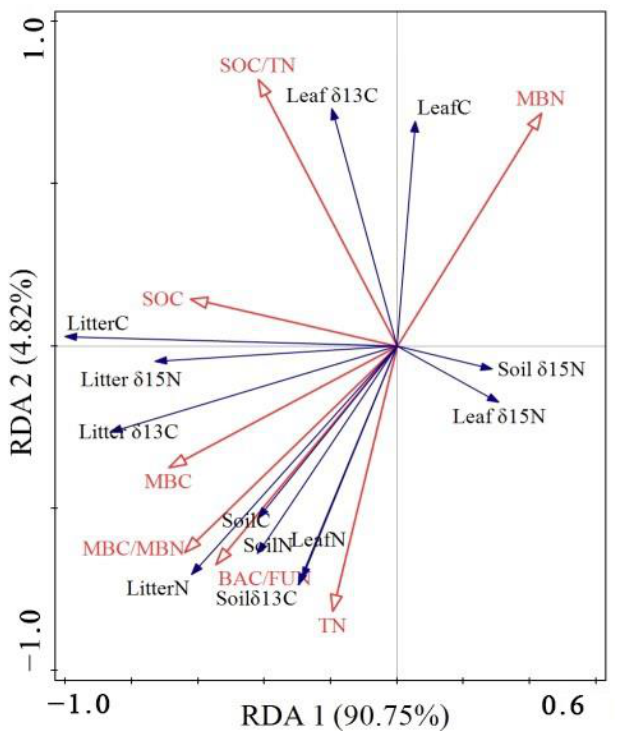
Figure 3. Redundancy analysis of artificial forest C, N, 13 C, 15 N and soil stoichiometry in the planta- tion.